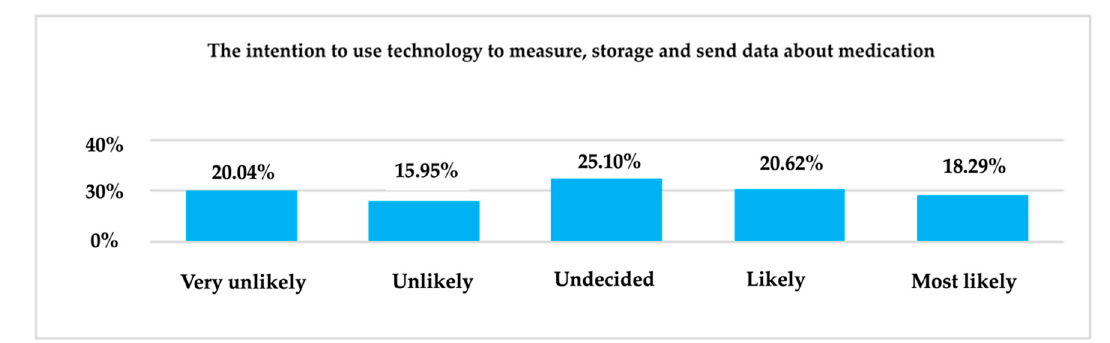
Figure 15. The intention of using technology—measurement, storage, and transmission of medication data.